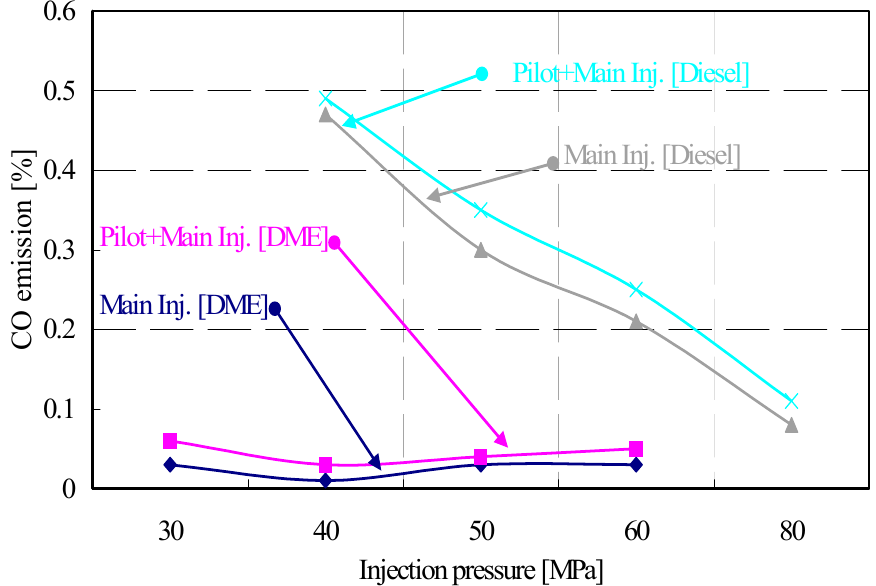
Figure 10. CO emission characteristics of diesel and DME engines with and without pilot injection as a function of injection